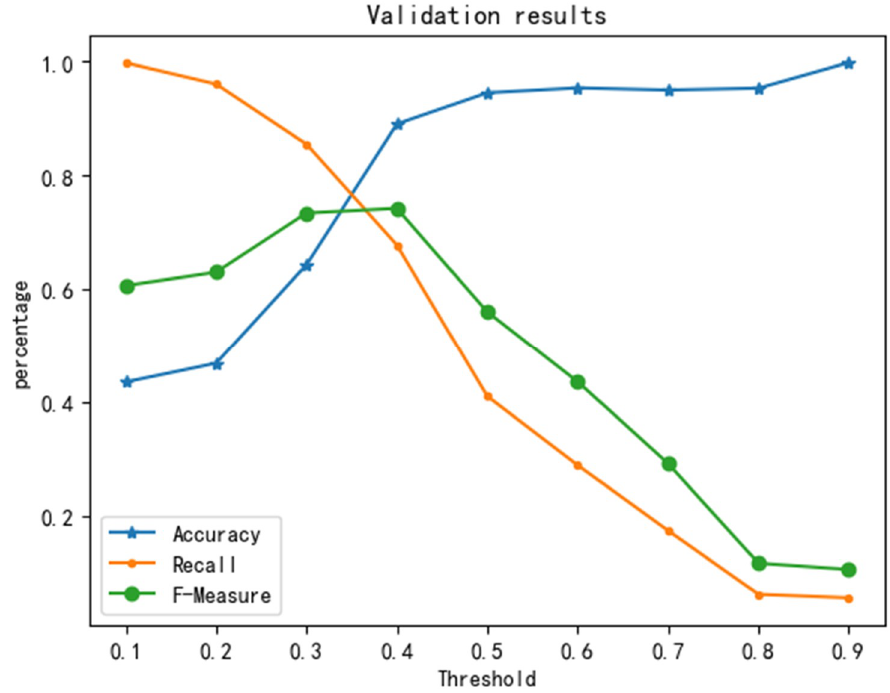
Figure 9. Verification results.